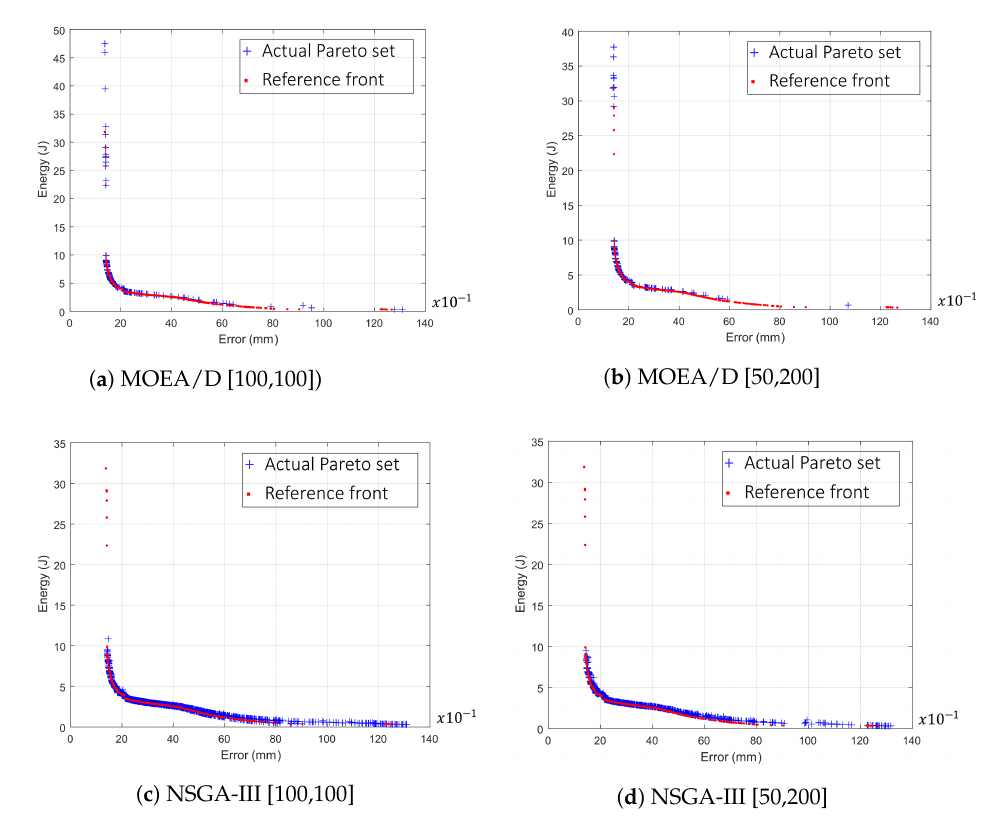
Figure 8. Pareto front from individual configurations of MOEA/D and NSGA-III from 15 inde- pendent executions. ( a ) MOEA/D with population size of 100 and 100 generations, ( b ) MOEA/D with population size of 50 and 200 generations, ( c ) NAGS-III with population size of 100 and 100 generations, and ( d ) NSGA-III with population size of 50 and 200